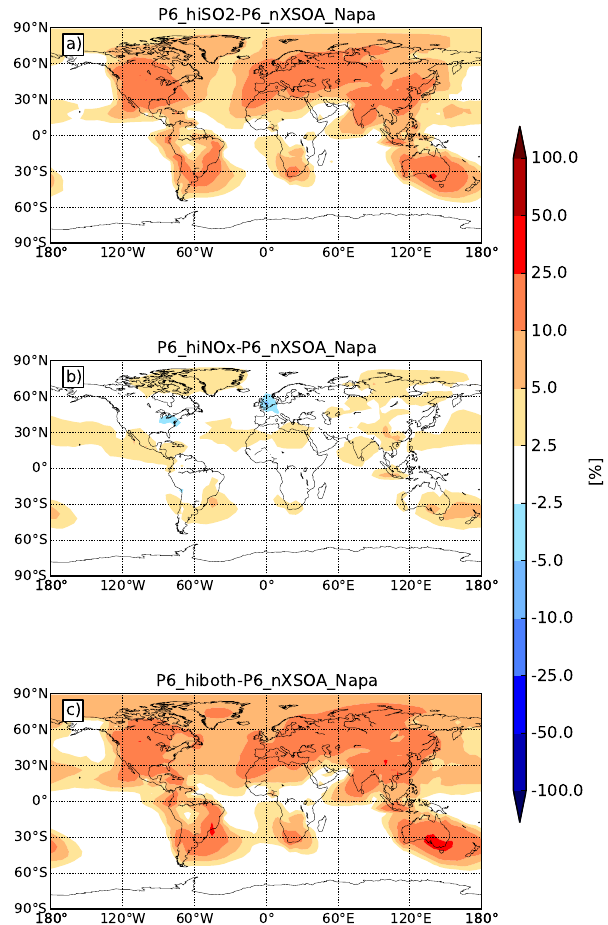
Figure 7. Change in annually averaged N80 between (a) P6_hiSO2, (b) P6_hiNOx, (c) P6_hiboth and P6_nXSOA_Napa.